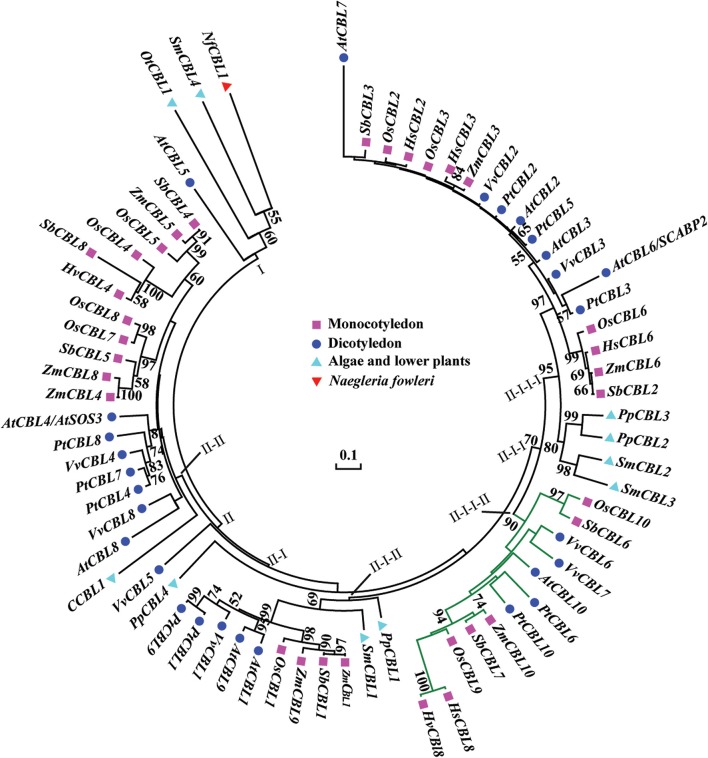
Phylogenetic relationships of CBL proteins from algae, lower plants, higher plants, and protozoan Naegleria fowleri (Nf). The NCBI accession numbers of the CBL proteins in this paper are presented in Table S2. The bar shows the evolutionary distance, and the number at the nodes represents the reliability percentage (%; only >50% is shown) of the bootstrap values based on 1000 replications. Codification: Hs, Hordeum spontaneum; Hv, H. vulbare; Os, Oryza sativa; Zm, Zea mays; Sb, Sorghum bicolor; At, Arabidopsis thaliana; Pt, Populus trichocarpa; Vv, Vitis vinifera; Ot, Ostreococcus tauri; C, Chlorella sp.; Pp, Physcomitrella patens; Sm, Selaginella moellendorfii.